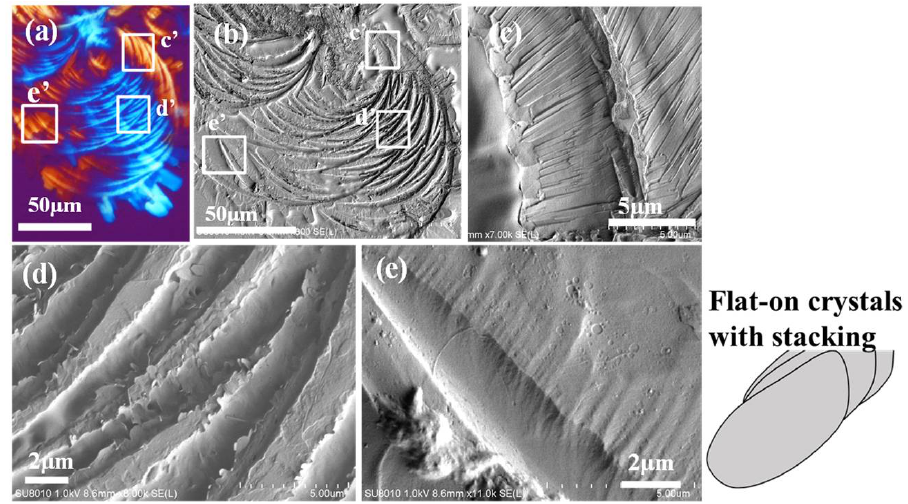
Figure 10. ( a ) POM graph, ( b ) SEM micrograph, and ( c – e ) zoom-in to squared regions of c’, d’ and e’ of ( b )